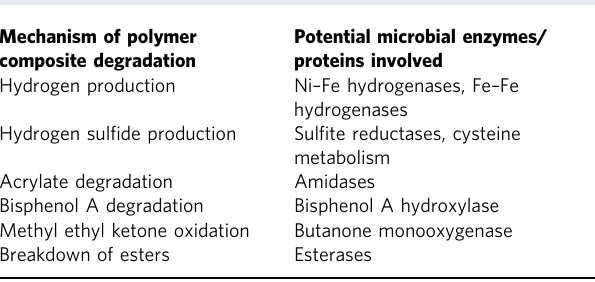
Fig. 2 Sampling scheme for experimental study of degradation of polymer composites. Soil samples (collected from the location shown on the map) were used as inoculum for establishment of bio fi lms on polymer composites. Three different conditions were set up: S + DI + A, DI + A, and S + DI. All experiments were conducted in duplicate. The experiment was conducted over 24 weeks. Details of speci fi c samples used for material characterization and DNA-sequencing-based microbial analyses are shown. Three different materials characterization procedures were performed using thermogravimetric analysis, Fourier-transform infrared spectroscopy, and nanomechanical characterization. Dissolved organic carbon analysis was performed on liquid samples collected from the incubation solution for each week. Microbial analyses included 16S rRNA amplicon sequencing and genome-resolved metagenomics (the number of circles/squares refers to the number of replicates that were used for each type of sequencing). The sampling location shown on the map was generated using the ggmap package in R with Open Street Maps: openstreetmap.org (see “ Collection of microbial samples ” in the Methods section). Map credit: © OpenStreetMap contributors. Table 1 Key microbial mechanisms associated with degradation of polymer